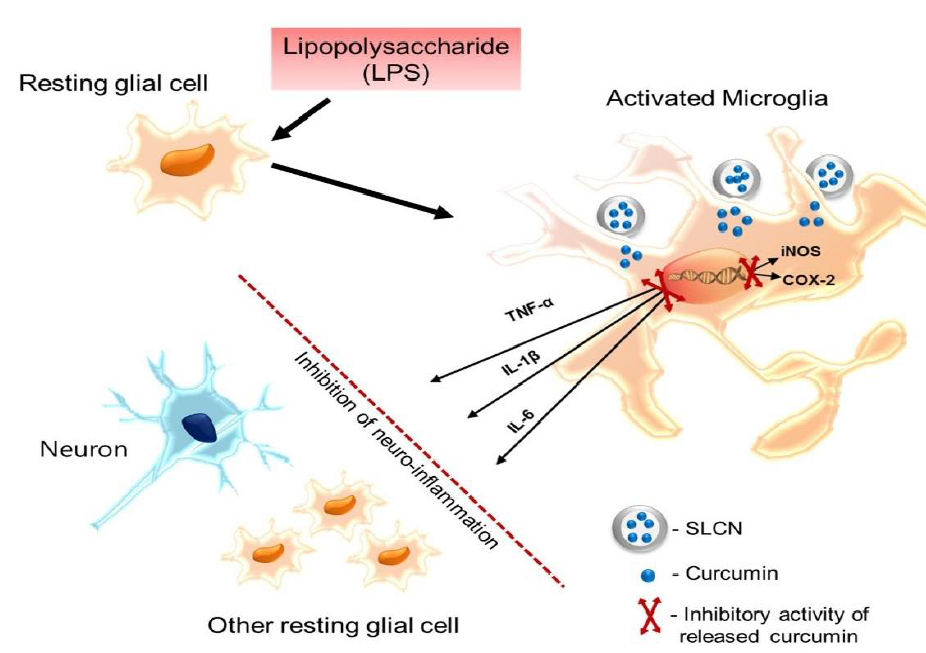
Figure 6. Postulated SLCN antineuroinflammatory mechanism of action in LPS-stimulated BV2 cells.